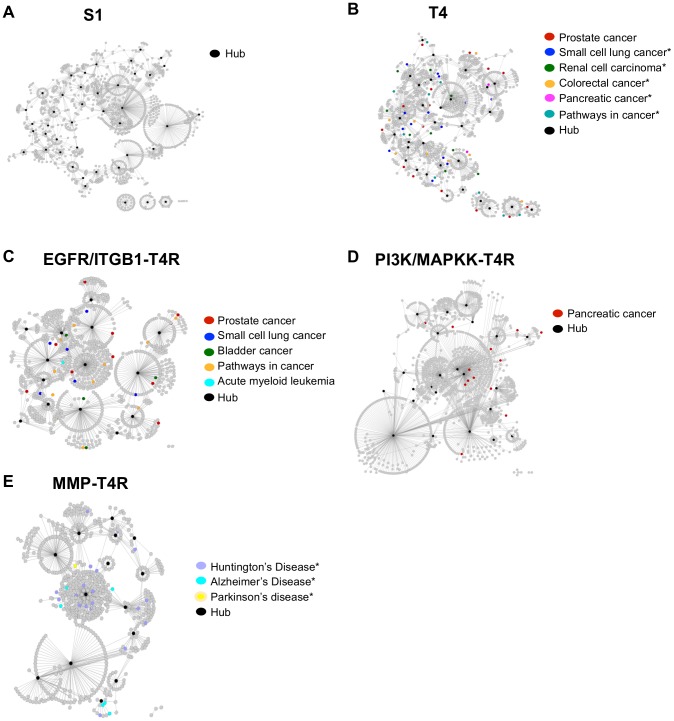
Diseases associated with the genes in the differential network of each breast cell state.(A) S1; (B) T4; (C) the EGFR/ITGB1-T4R group; (D) the PI3K/MAPKK-T4R group; and (E) the MMP-T4R group. In each plot, the differential network for the corresponding cell state is shown. Nodes represent genes; edges represent interaction of the genes. Diseases associated with the genes in the network (unadjusted p-values<0.05) are color-coded and shown on the right; genes associated with a certain disease are also colored based on the color code for the corresponding disease. An asterisk indicates a disease that is significantly enriched in the corresponding differential network.